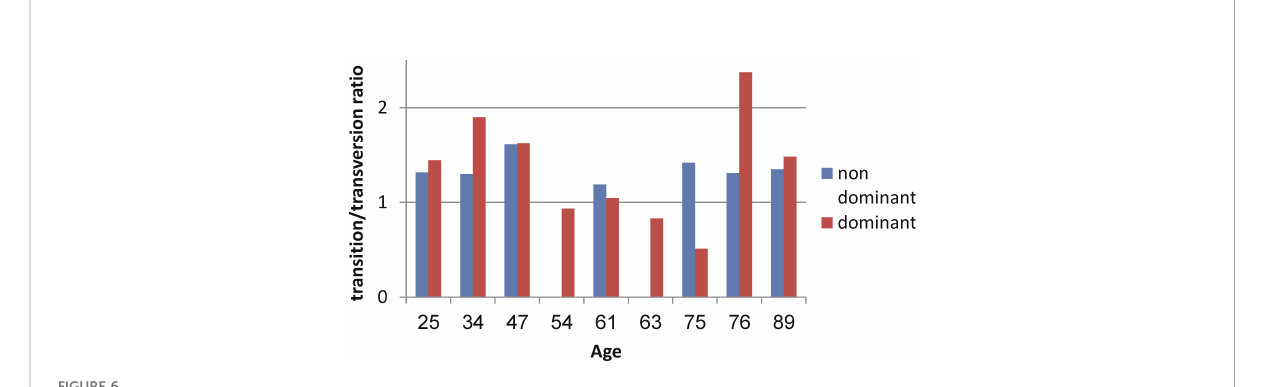
FIGURE 6 Transition/transversion ratios in dominant and non-dominant